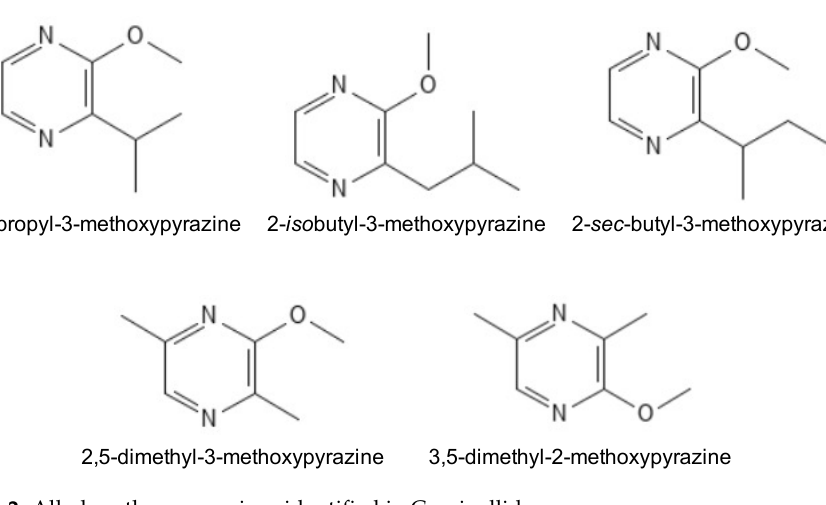
Figure 2. Alkyl-methoxypyrazines identified in Coccinellidae.